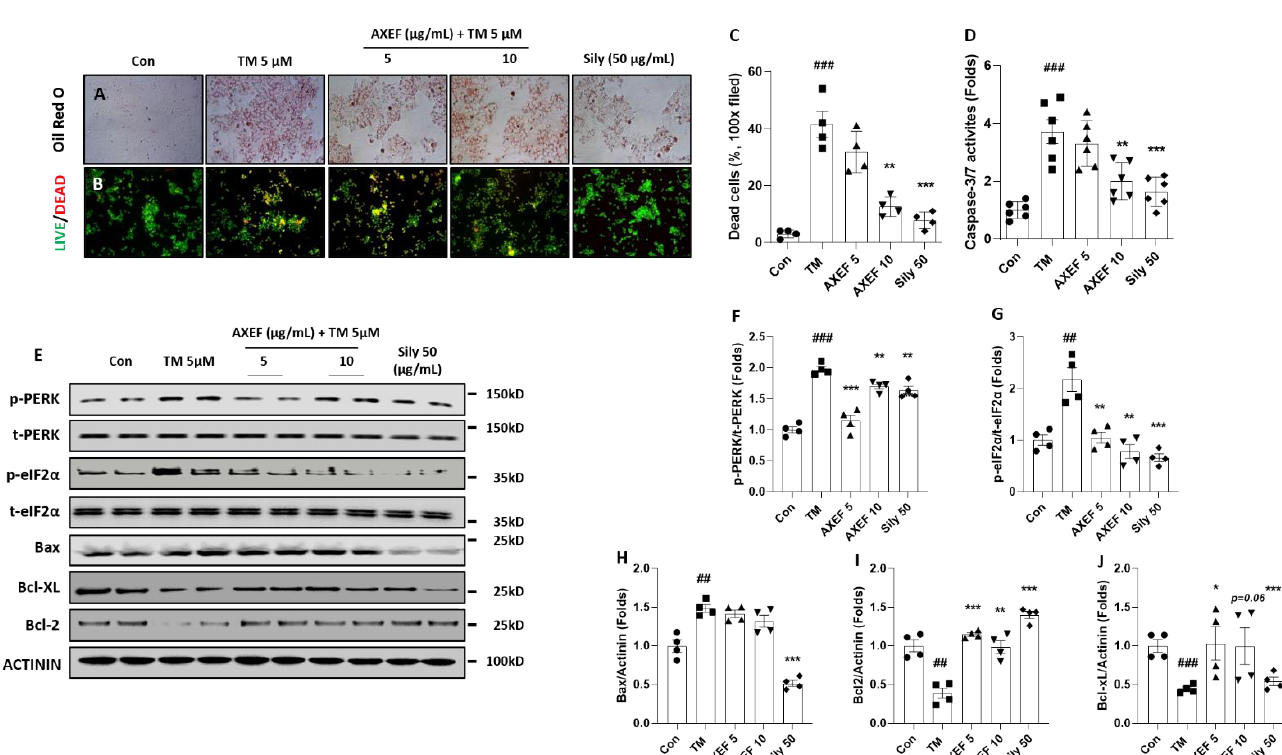
Figure 5. Effects of AXEF on the ER stress-induced in vitro NASH model of cellular damage. ( A ) Oil Red O staining of Huh7 cells of TM-induced (5 µM) ER stress in vitro NASH model using treatment and ( B ) LIVE/DEAD cell assays. ( C ) Quantitative analysis of LIVE/DEAD cell assay. ( D ) Cellular levels of caspase-3/7 activity. ( E ) Western blot analysis of ER stress and apoptosis-related molecules from Huh7 cell lysate. ( F – J ) Data are expressed as the mean ± SD ( n = 4 for Oil Red O staining; n = 6–8 for caspase-3/7 activities). ## p < 0.01; ### p < 0.001 for the Con vs. TM, * p < 0.05; ** p < 0.01; *** p < 0.001 for TM vs. AXEF or Sily 50. Images were captured using light microscopy (100 × magnification) or fluorescence filter equipped microscope (100 ×